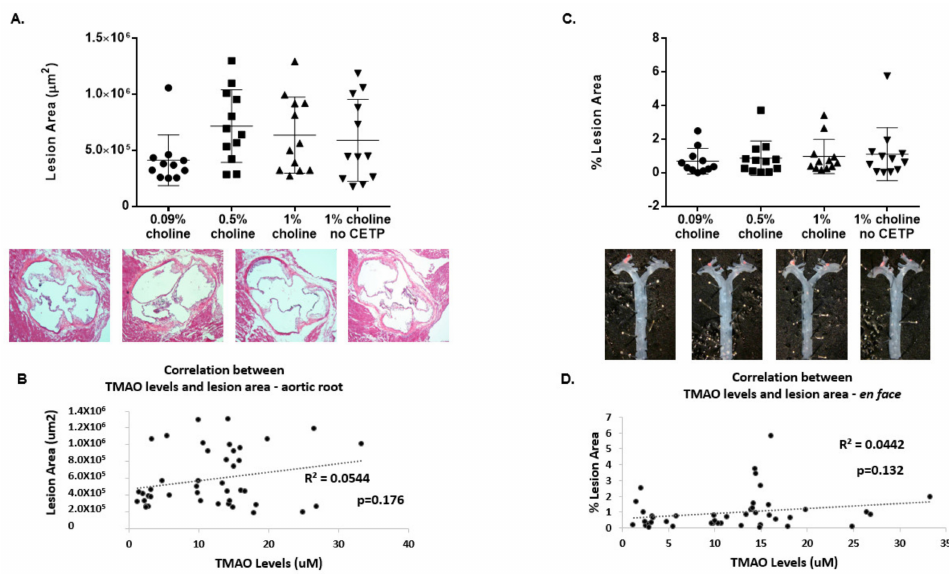
Figure 2. Effect of TMAO production on aortic lesions in vivo. Apoe − / − mice expressing CETP or controls (no CETP) were fed chow with supplementation of low, moderate and high choline